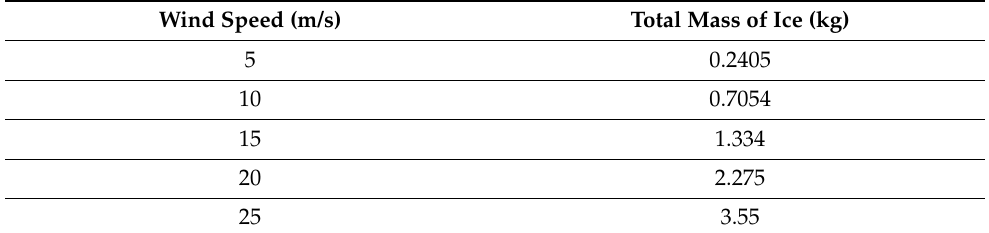
Figure 3. The ice distributions of cross beam at different wind attack angles. ( a ) The wind attack angle is +26.6 ◦ . ( b ) The wind attack angle is − 26.6 ◦ . Table 1. Total mass of ice on cross beam surface at different wind